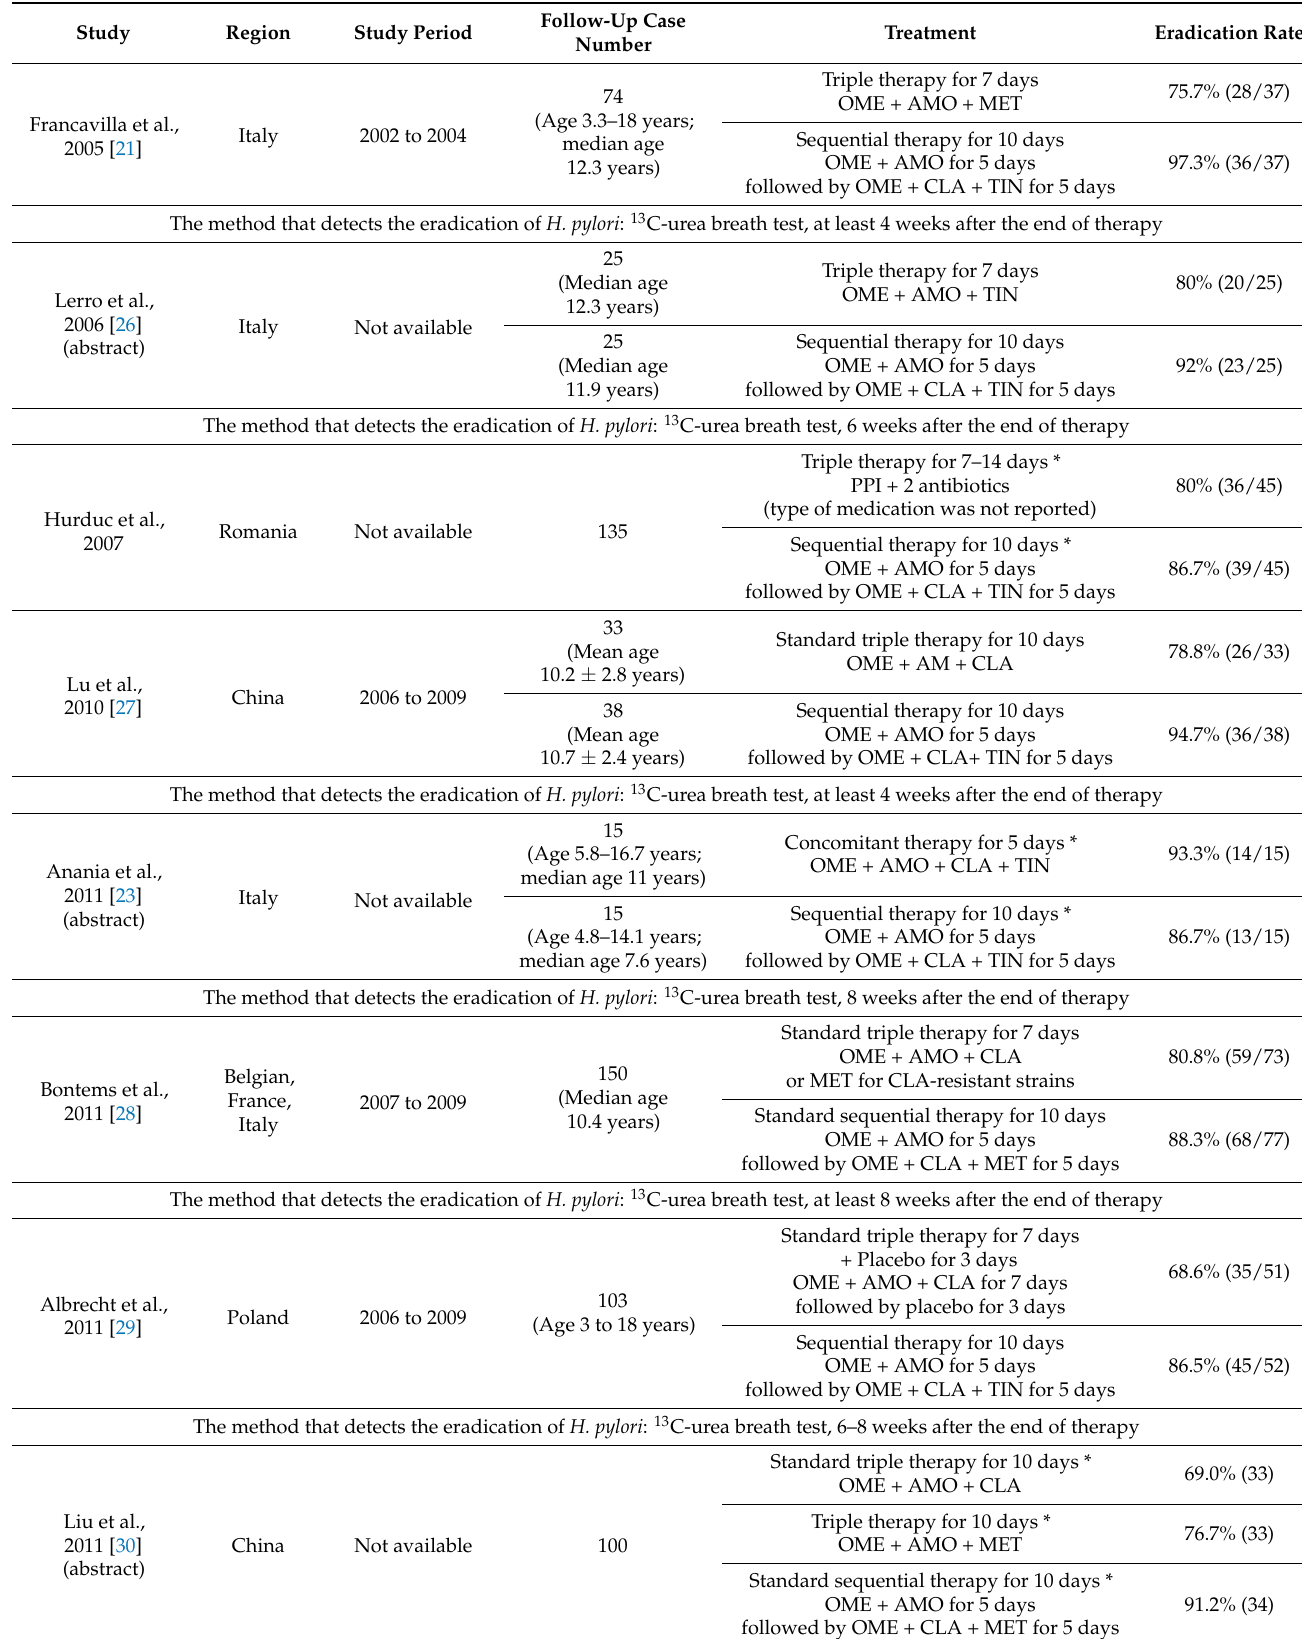
Table 2. Eradication rates of first-line treatment for pediatric H. pylori